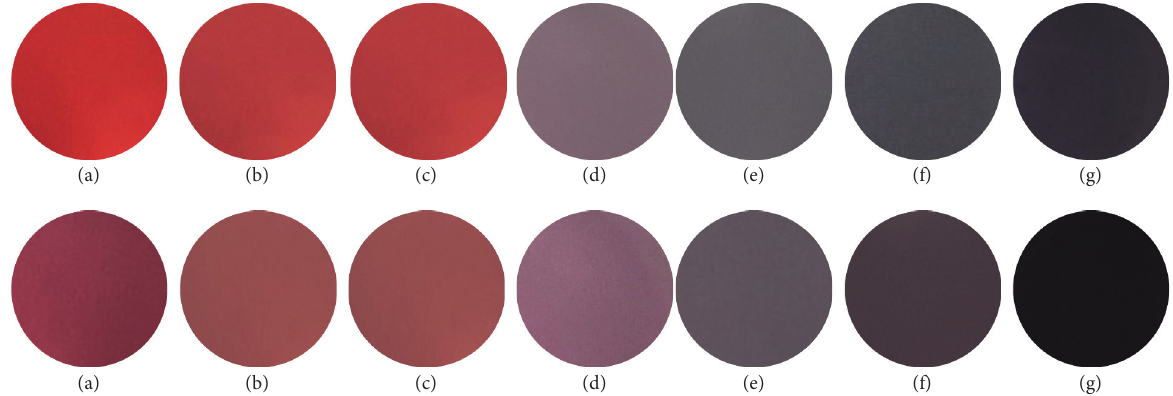
Figure 7: Colour images for (i) Ac-Cit-HAuNPs and (ii) Ac-Cit-MAuNPs complexes in the presence of different concentrations of Ac ((a) 0.00mM, (b) 1.00 × 10 − 5 mM, (c) 1.00 × 10 − 3 mM, (d) 0.40mM, (e) 1.00mM, (f) 4.00 mM, and (g) 8.00mM.